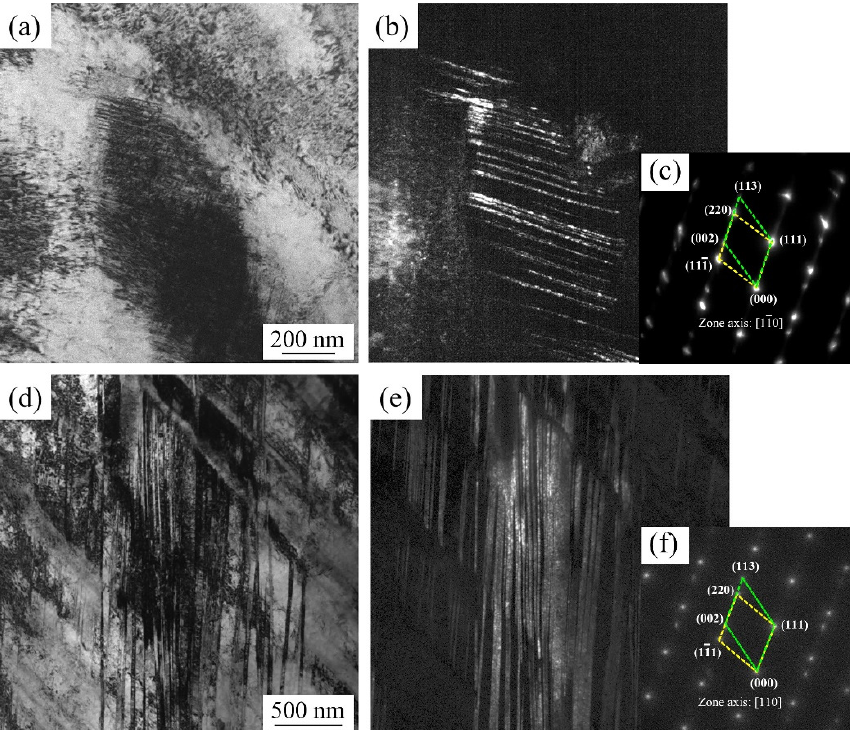
Figure 10. TEM micrographs of deformation twins microstructure of experimental steels: ( a – c ) steel 1# and ( d – f ) steel 2# with ( a , d ) bright field images, ( b , e ) dark field images and ( c , f ) corresponding SAED patterns.